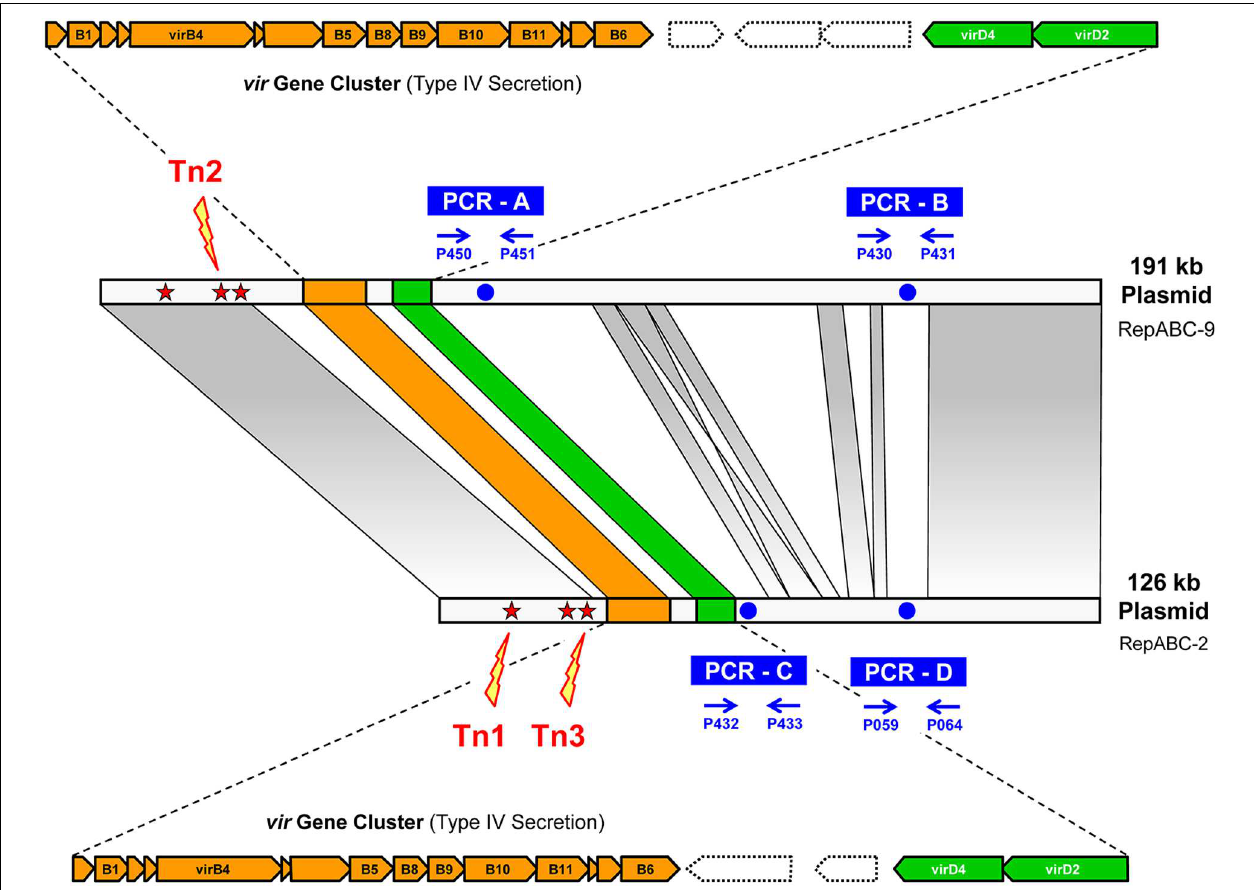
FIGURE 1 | Synteny plot of the 191 and 126-kb repABC -type sister plasmids of Dinoroseobacter shibae DSM 16493 T (pDSHI01, pDSHI03). Long-range homologies with approximately identical sequences are shown with fading gray bars. The virB and virD operons of the type IV secretion system (T4SS) are highlighted in orange and green, respectively. Blue arrows indicate the localization of primer binding sites for PCR-based differentiation of the two sister plasmids. Red stars represent putative integration sites of three mariner transposons (Tn), whose precise integration site could not be determined via arbitrary PCR (Ebert et al., 2013). Yellow bolts show the actual transposon integration sites that were determined via conjugative transfer into Phaeobacter inhibens DSM 17395 in the current study. Tn1: Dshi_3944 (126-kb pDSHI03); Tn2: Dshi_3624 (191-kb pDSHI01); Tn3: Dshi_3964 (126-kb